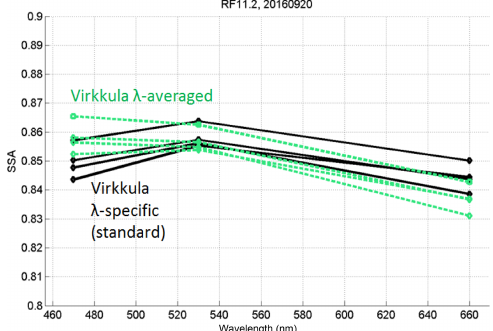
Figure A2. Profile-averaged extinction-weighted SSA for the case study shown on 20 September 2016. The impact on the 470nm SSA (and consequently, the spectral shape) is the most notable differ- ence. We attribute this spectral shape to the stronger increase in aerosol absorption at the shortest wavelength – while scattering also increases, it exhibits a smaller wavelength dependence than does absorption (Fig.